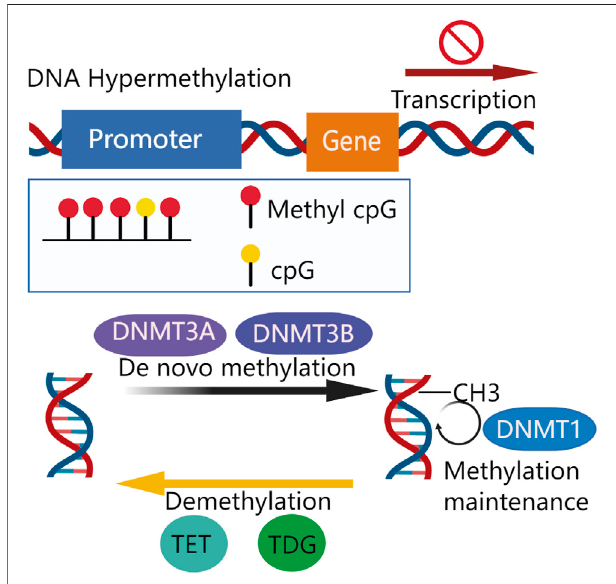
FIGURE 1 | Overview of DNA methylation in CpG of the gene promoter